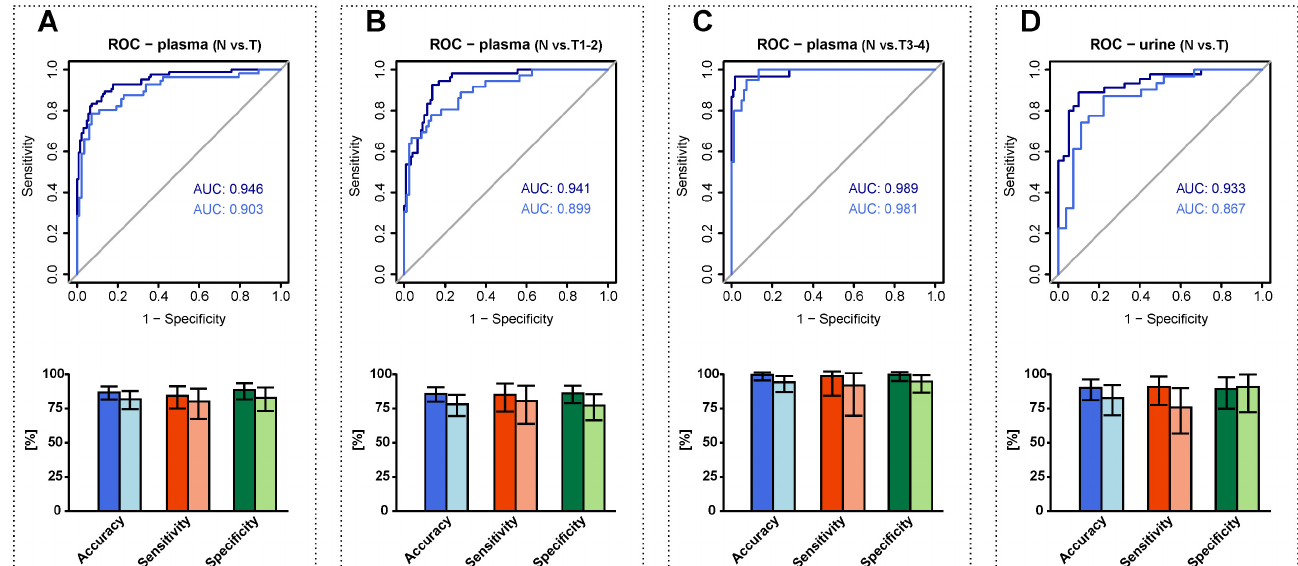
Figure 6. Potential of the studied lipids in case of clinical cancer detection. Receiver operating characteristic (ROC) curves illustrate the diagnostic ability of logistic regression with ridge penalty. The dark blue color of the lines refers to the training data set prediction and the light blue to the testing data set prediction. For each case, the areas under the ROC curves (AUC) are presented in dark blue for the training data set prediction and light blue for the testing data set prediction. The models were constructed for all plasma samples, prediction of RCC ( A ); for plasma samples, prediction of early-stage RCC ( B ); for plasma samples, prediction of late-stage RCC ( C ); and for all urine samples, prediction of RCC ( D ). Bar charts with 95% confidence intervals (CI) represent training accuracy (dark blue), sensitivity (dark red), specificity (dark green), and testing accuracy (light blue), sensitivity (light red), and specificity (light green).